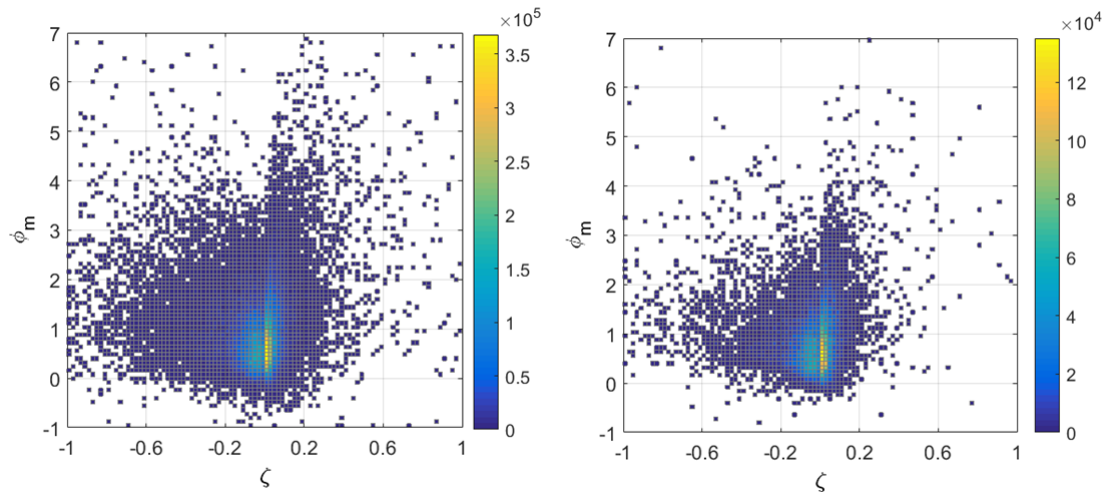
Figure 7. Distribution of the ϕ m and ζ by using two different time scales of 10 min and 30 min, respectively.